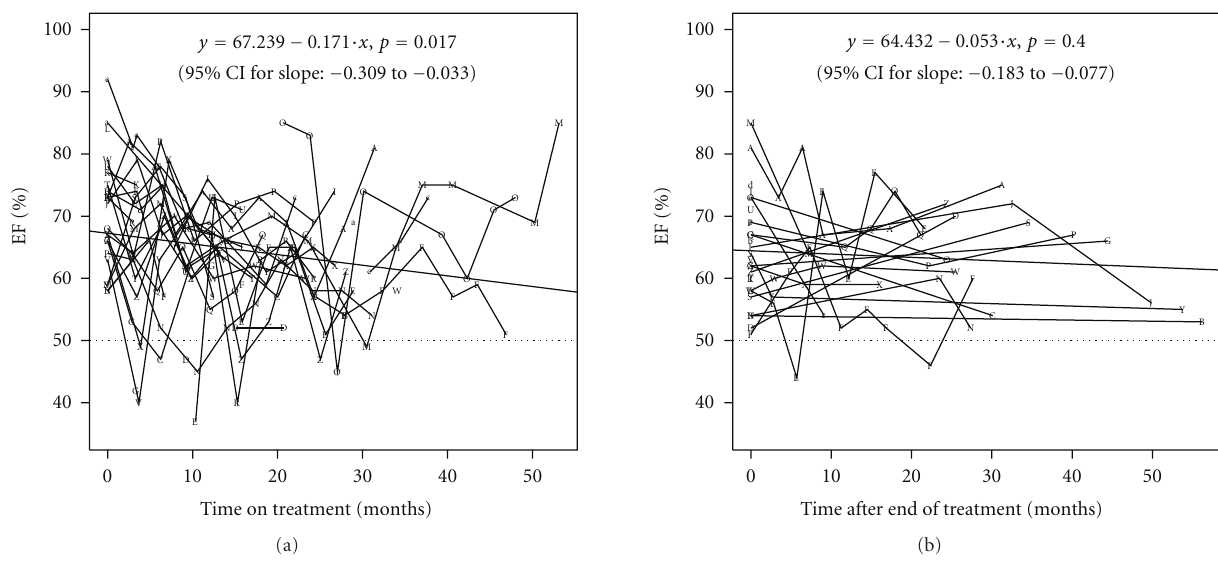
Figure 1: (a) Time course of left ventricular ejection fraction (EF%) during mitoxantrone treatment of 19 patients. In several patients, time on treatment was prolonged due to temporary interruptions of treatment. The time course of individual patients is denoted by the same letter throughout Figures 1(a) and 1(b). (b) Time course of left ventricular ejection fraction (EF%) after the end of mitoxantrone treatment in the same 19 patients is shown in Figure